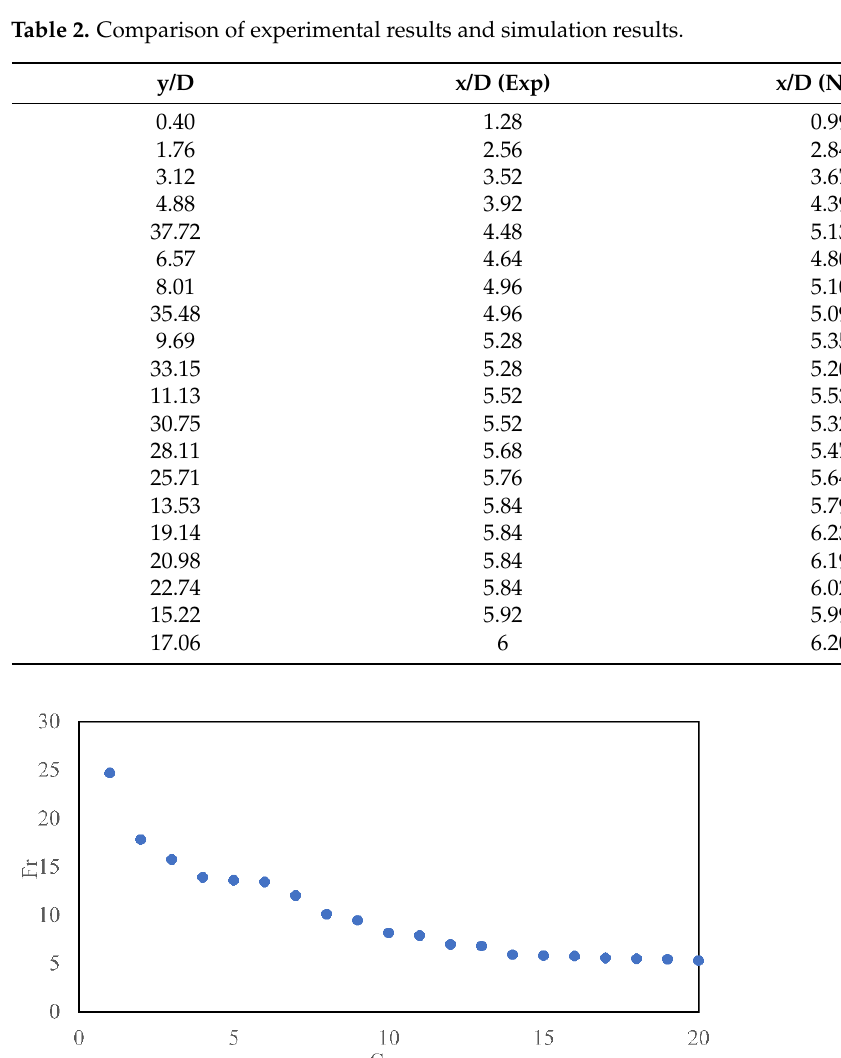
Figure 3. The normalized concentration field of the central plane under different conditions ob- tained by CFD model. Numerical data were extracted using ParaView and MATLAB, and in the dataset the mean, minimum, maximum, and median values of Fr were 9.993, 5.305, 24.676, and 8.022, respectively. The standard deviation, variance, kurtosis, and bias were 5.079, 25.801, 4.109, and 1.267, respectively. The mean, minimum, maximum, and median values of the nor- malized concentrations were 0.33, 0, 1, and 0.28, respectively. The standard deviation, var- iance, kurtosis, and skewness of the normalized concentrations were 0.28, 0.08, 2.09, and 0.49, respectively. Because this model has been validated, the above 20 cases were utilized as measured data for training and testing machine learning models. 3.2. Results of CFD and CNN Joint Method